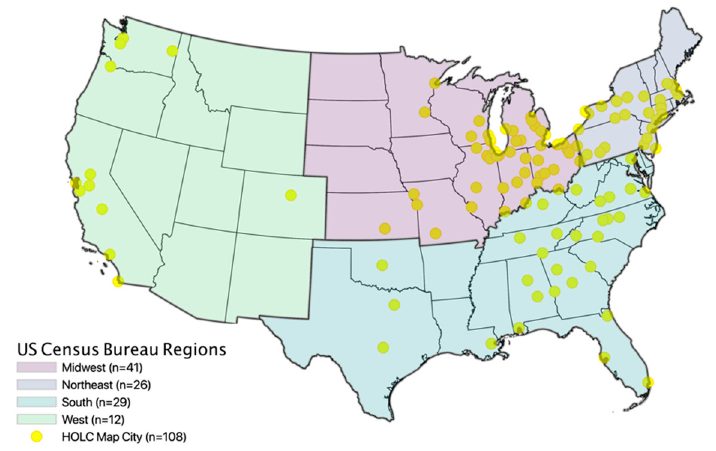
Figure 1. Map of 108 US cities with HOLC Residential Security maps included in this study. These areas may include several smaller-area HOLC maps that have been aggregated into a larger urban area (Supplementary Materials